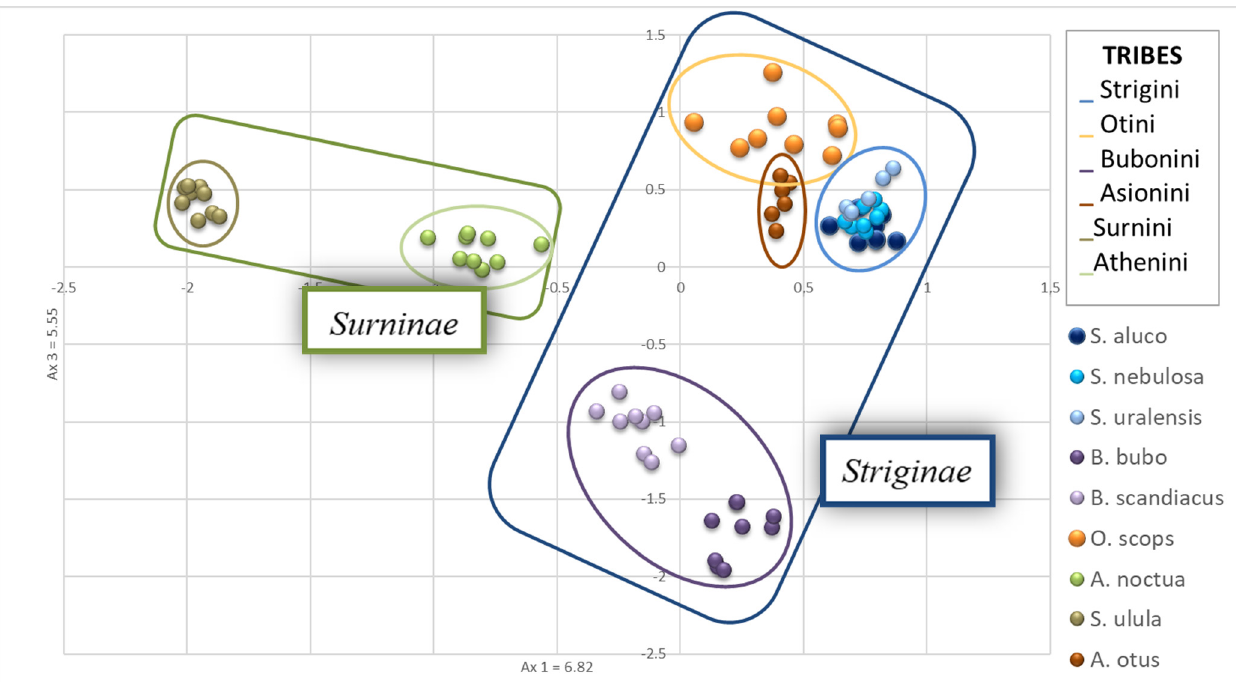
Figure 2. Principal Component Analysis plot obtained using Genetix and visualized in Excel. Strix sp. overlapped while Bubo bubo and Bubo scandiacus plotted very closed each other. Surnia ulula individuals diverged consistently from other species. Ovals in different colors represent the distribution of individuals belonging to six tribes of Striginae and Surninae, in the blue and green squares,